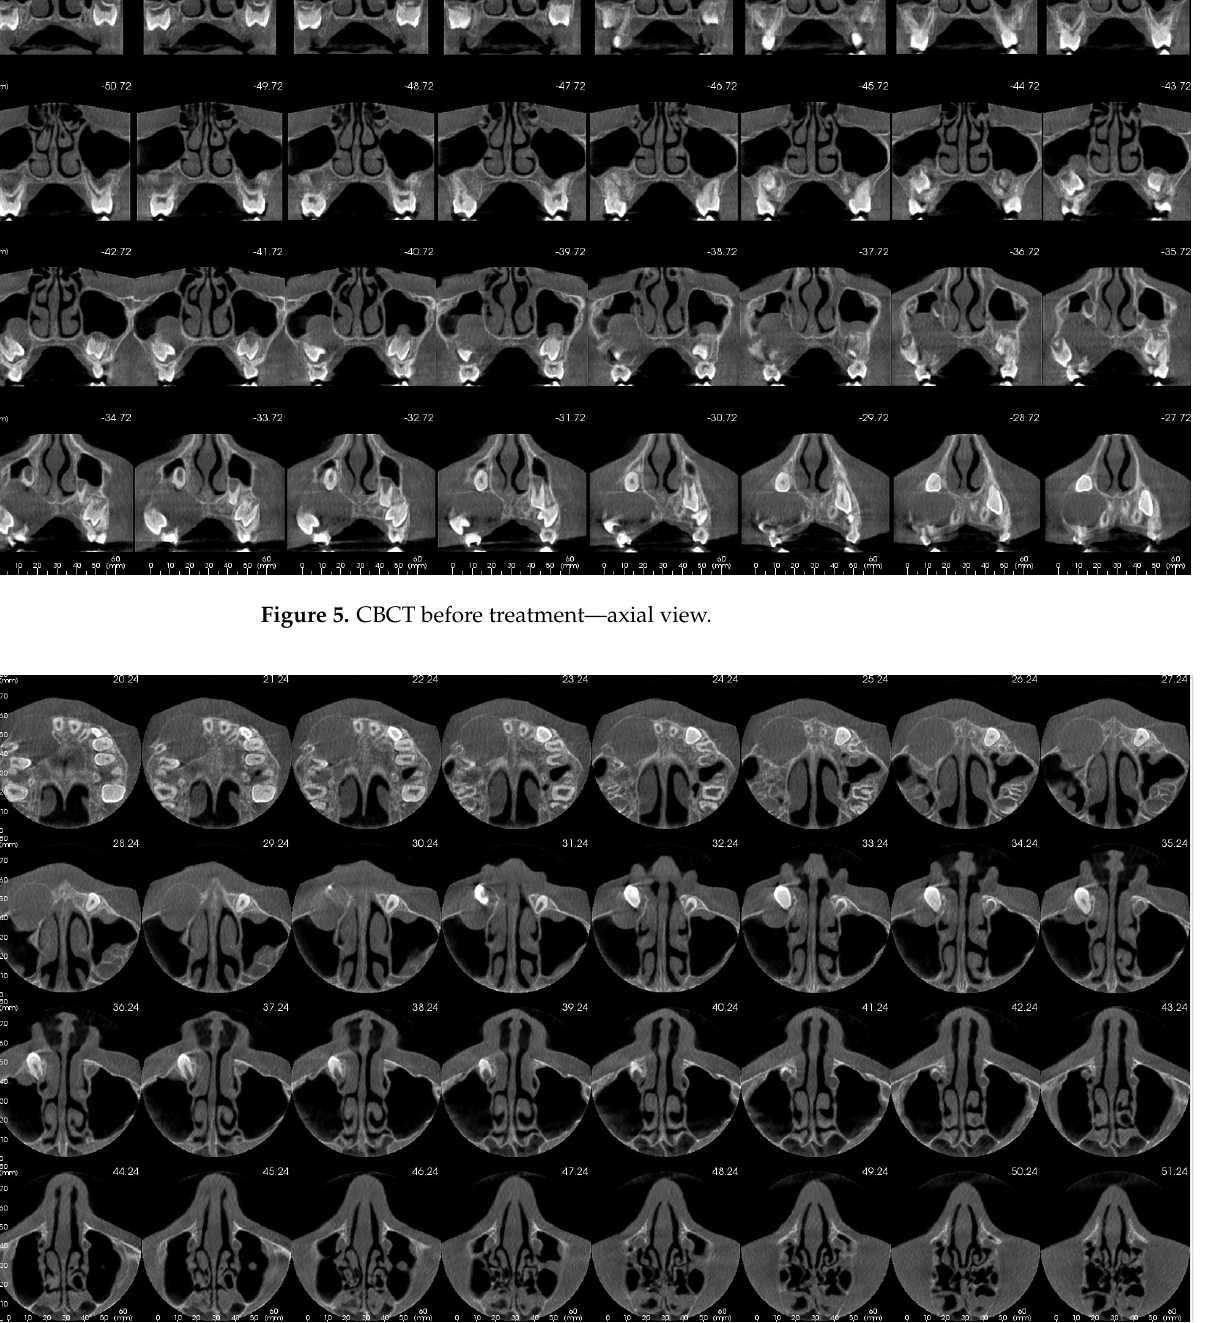
Figure 6. CBCT before treatment—coronal view.